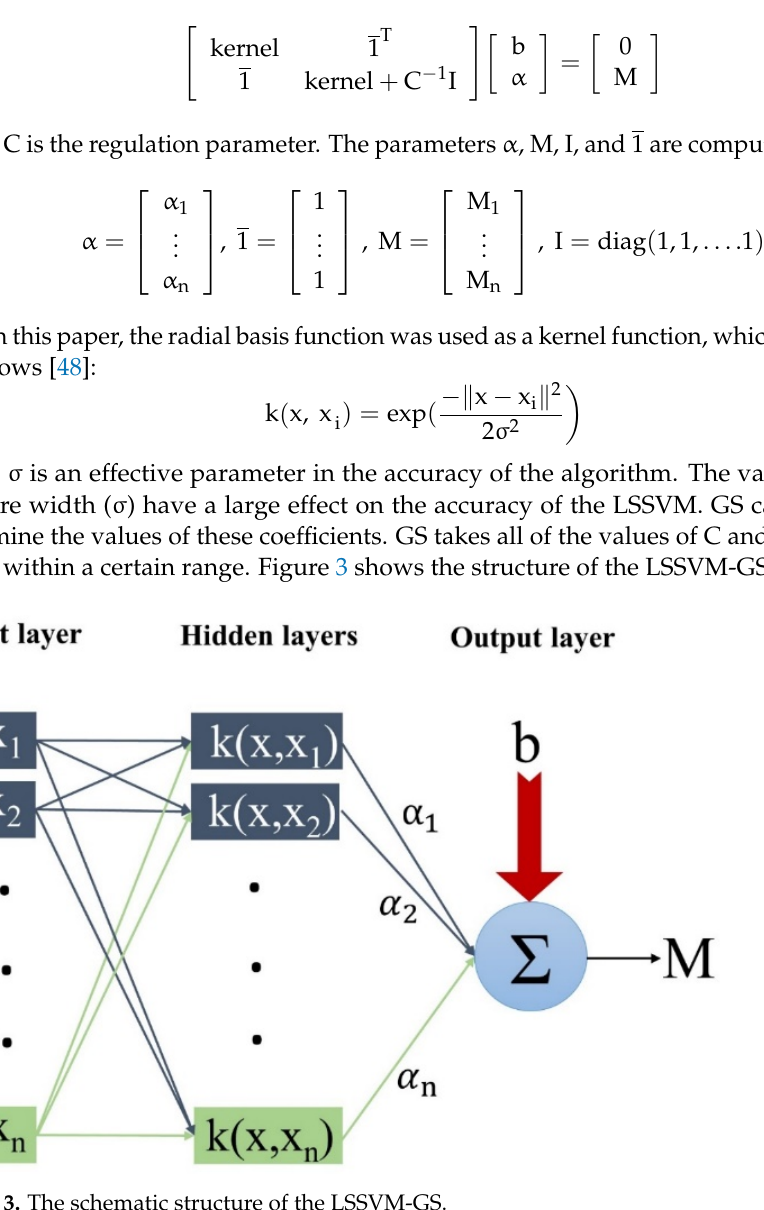
Figure 3. The schematic structure of the LSSVM-GS.